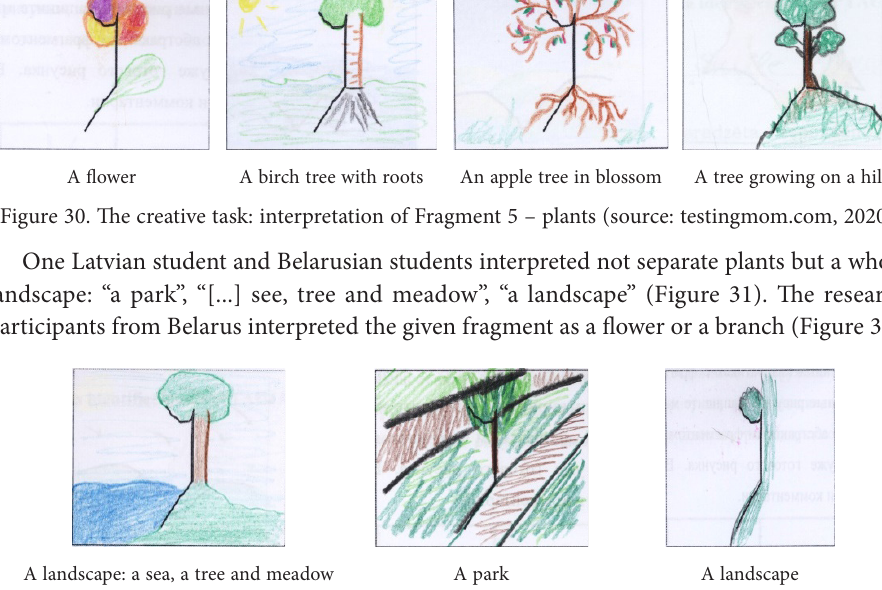
Figure 31. The creative task: interpretation of Fragment 5 – landscape (source: testingmom.com, 2020) The third biggest group of interpretation images of Fragment 5 consists of characters